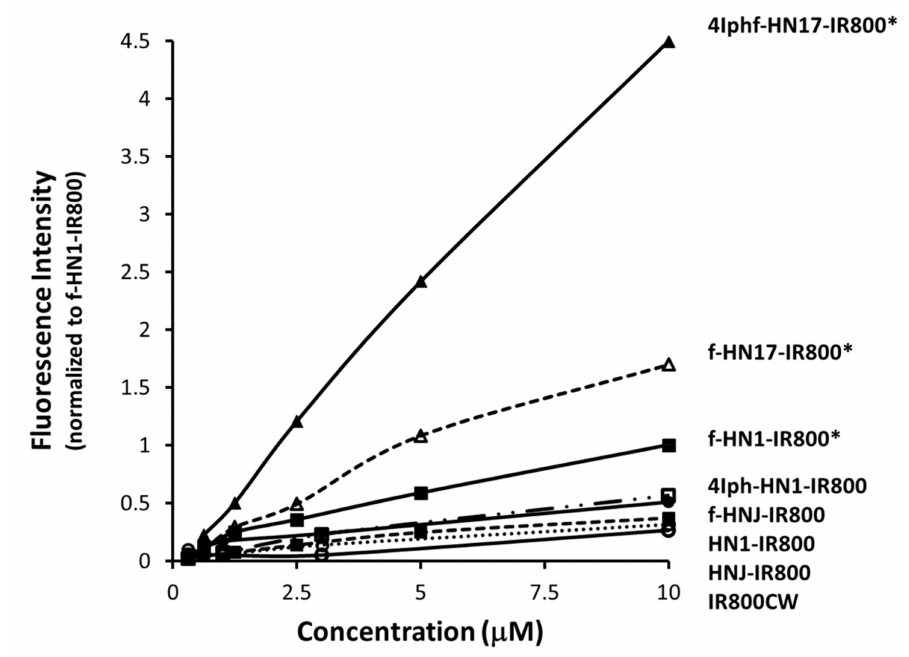
Figure 2. Relative uptake of peptides as IR800 conjugates, as a function of incubation concentration in cultured Cal 27 cells measured by fluorescence of the washed, lysed cells after 2 h of incubation. Cal 27 cells were incubated with the agents at 0.625–10 µ M. Cell uptake is normalized to f-HN1-IR800 at 10 µ M (1.0 on the vertical scale). The bottom most curve is the unconjugated IR800 dye as the carboxylate. * indicates statistical di ff erence from HN1-IR800 at p < 0.05. Tables S2 and S3 detail methodology and report numerical data points in the figure, with uncertainties and p values.